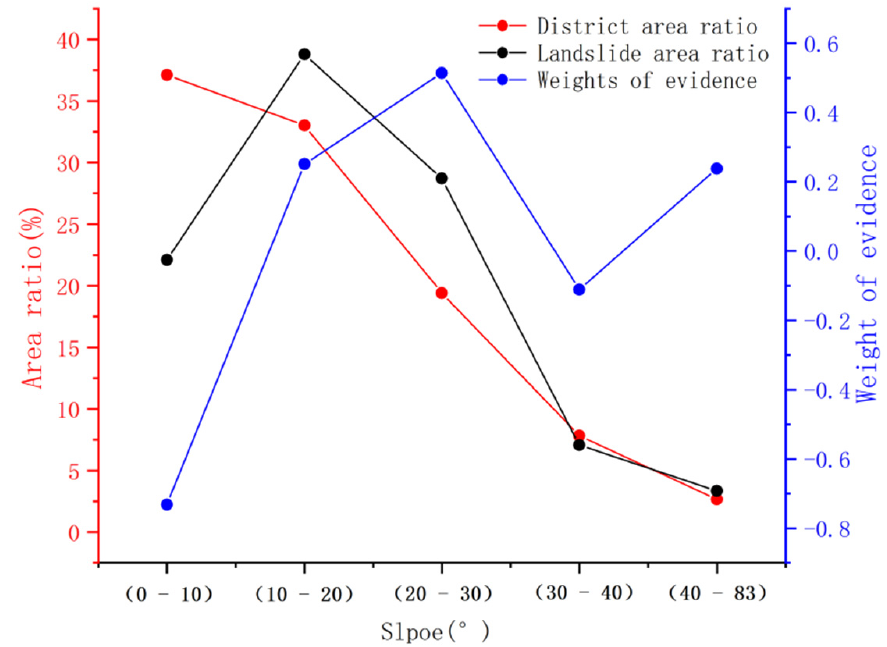
Figure 6. Slope statistical analysis results.